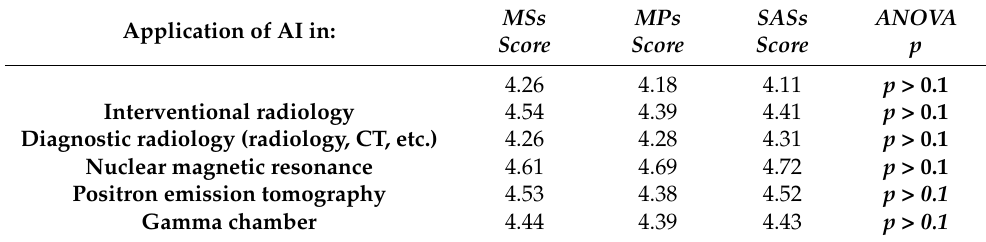
Table 3. Specific outcome of the opinion on the application on the medical imaging.